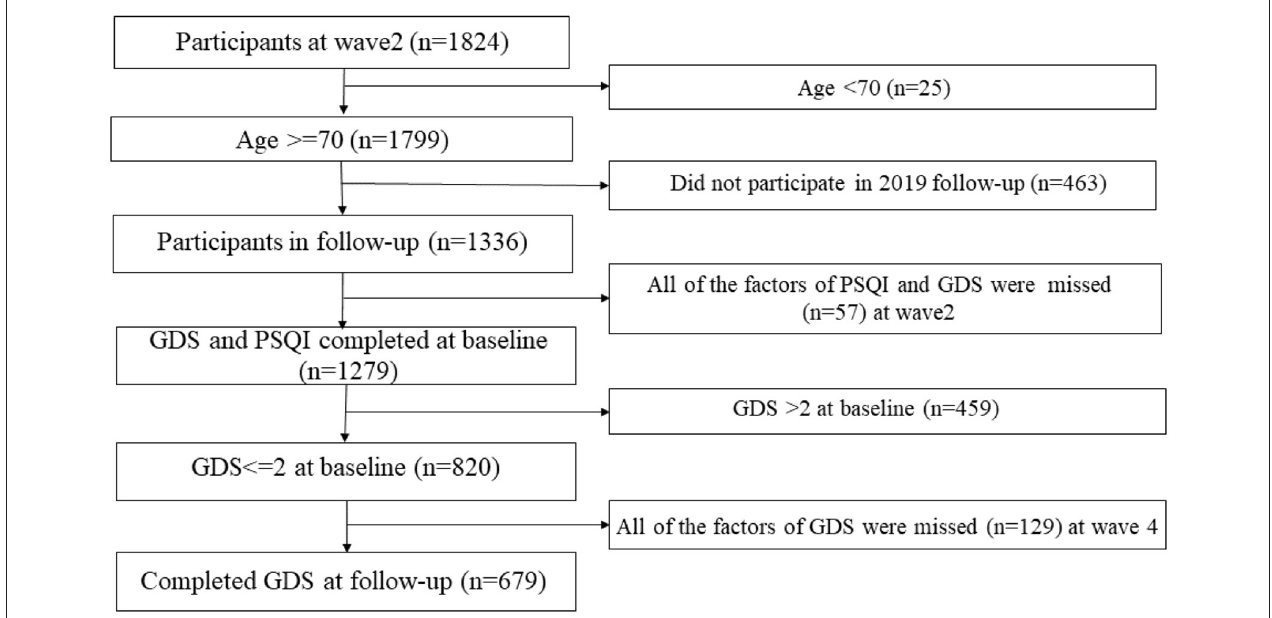
FIGURE 1 | Recruitment and inclusion of participants. Reasons for not including participants are given on the right. GDS, Geriatric Depression Scale; n , number; RuLAS, Rugao Longevity and Aging Study.